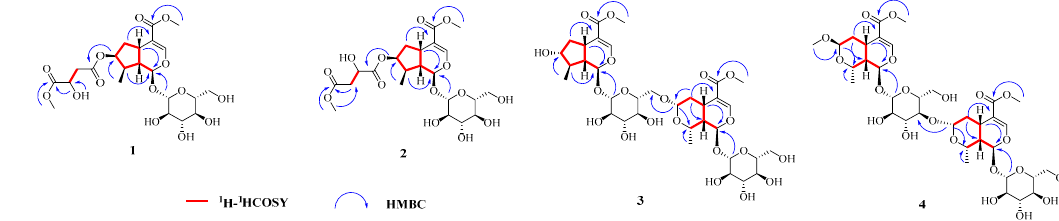
Figure 2. The key HMBC and 1 H- 1 H COSY correlations of compounds 1 – 4. The molecular formula of compound 3 , C 34 H 50 O 20 , was determined based on its HRESIMS at m/z 801.2795 [M+Na] + and 13 C NMR data (Table 2). The NMR data of 3 were consistent with those of cornuside L [21], except for the chemical shifts of C-7 ( 3 , δ C 79.5; cornuside L, δ C 75.1), C-8 ( 3 , δ C 44.3; cornuside L, δ C 42.5), and C-10 ( 3 , δ C 17.6; cornuside L, δ C 13.8). All of the aforementioned information and signals of HMBC, COSY, and HSQC confirm the planar structure of 3 was identical to cornuside L. However, the NOESY cor- relations (Figure 3) showed that H-5, H-7, H-9, H-10, H-5 ″ , H-7 ″ , H-8 ″ , and H-9 ″ were β - oriented, whereas, H-1, H-8, H-1 ″ , and H-10 ″ were α -oriented. Acid hydrolysis and chiral- HPLC analysis suggested the sugar moiety was D -glucose. Thus, the structure of com- pound 3 was determined and named neocornuside C, as shown in Figure 1. More details are shown in Supplementary Materials. Table 2. 1 H NMR (500 MHz) and 13 C NMR (125 MHz) data ( δ in ppm, J in Hz) for compounds 3 – 4 a . 3